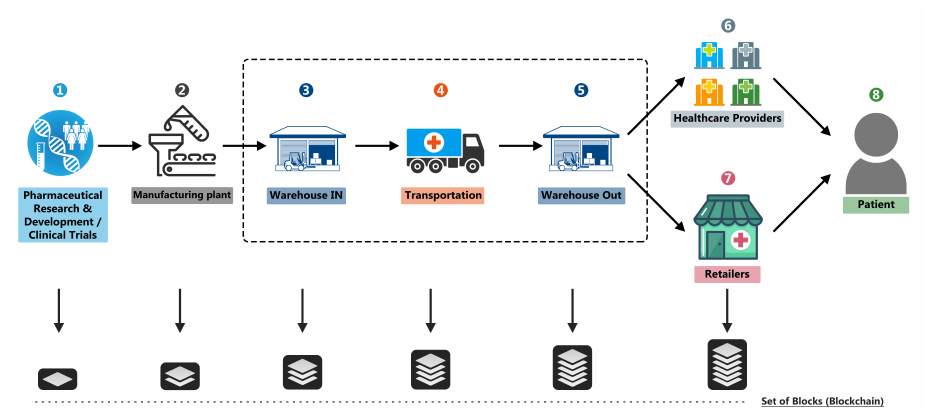
Figure 4. Supply chain management in